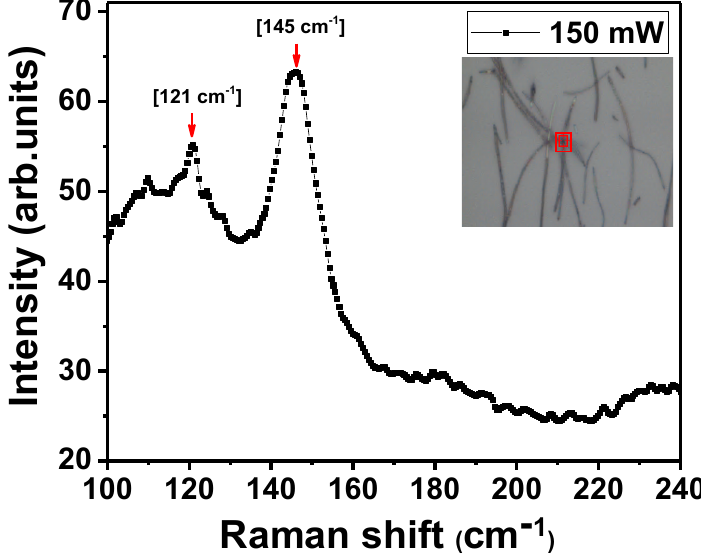
Figure 5. Raman spectrum obtained from a single a - InSb NWs at room temperature. Inset shows an optical image of the region (crossed NWs) from where the Raman spectrum was collected. The two peaks at ∼ 145 cm − 1 and 121 cm − 1 are attributed to a - InSb . The spectrum was obtained with 150 mW of laser